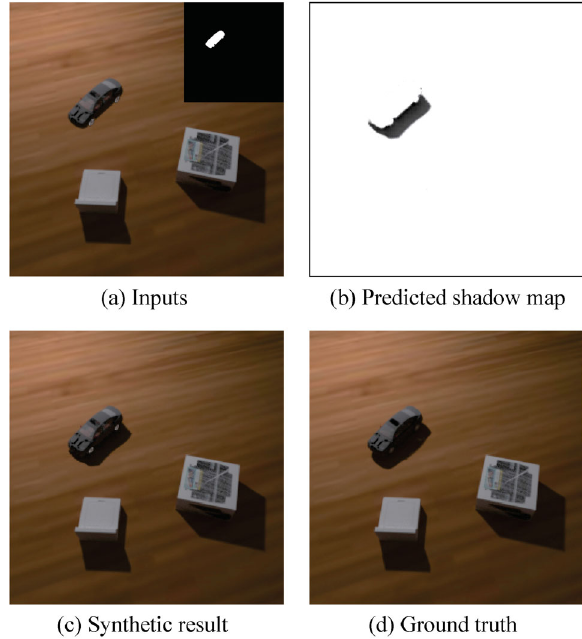
Fig. 1 Input and output of ShadowGAN. (a) Given an input target scene with original objects and a virtually inserted object (here, a toy car), as well as the object mask ((a) top-right), ShadowGAN predicts a shadow map (b) which can be used to synthesize the shadowed result (c) with a simple pixel-wise product operation. The ground truth result is shown in